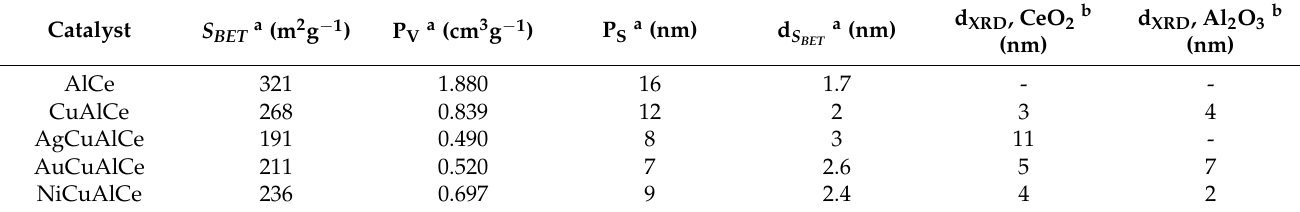
Table 1. Specific surface area (S BET ), pore volume (PV), pore size (PS), crystallite size of oxide (d (cid:1845) (cid:3003)(cid:3006)(cid:3021) , supports and